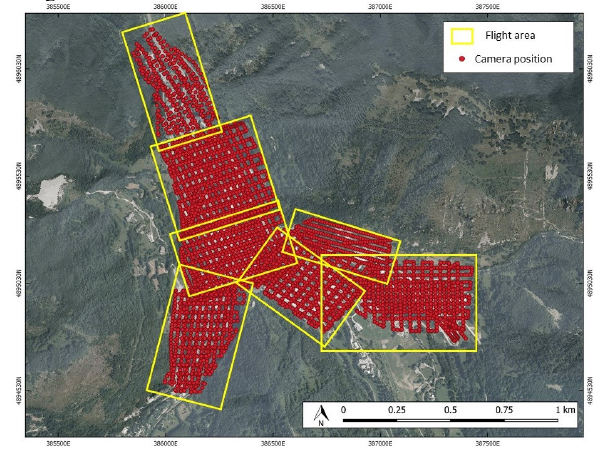
Figure 2. UAV flights performed in the area of Limone Piemonte village. 7 flights were carried out (yellow rectangles) and a total number of 5225 images were acquired (red dots)